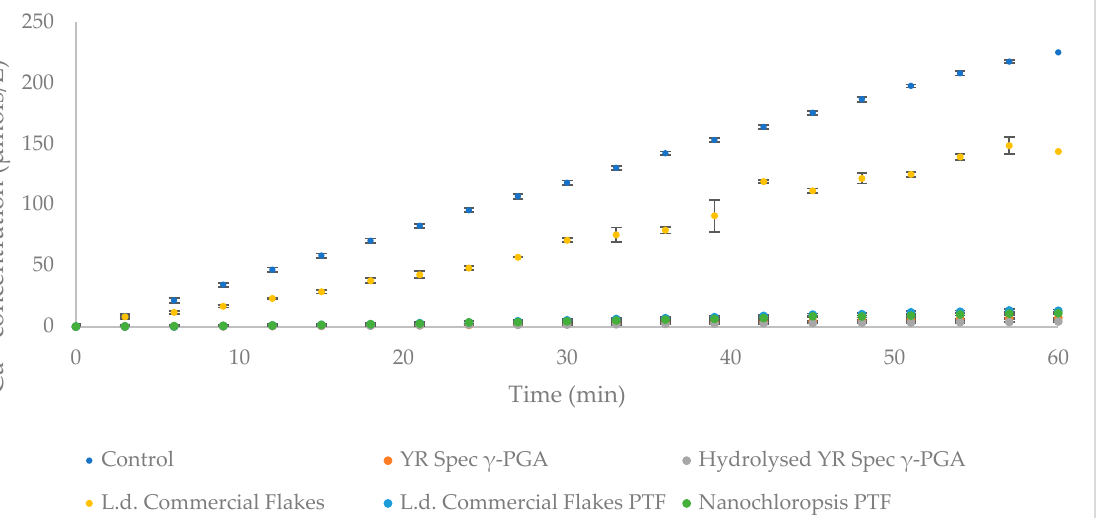
Figure 7. FT-IR profiles of HAp disc before and after 1 h acidic challenge in the presence of γ -PGA. Interaction peak, between γ -PGA and HAp disc, circled in purple.